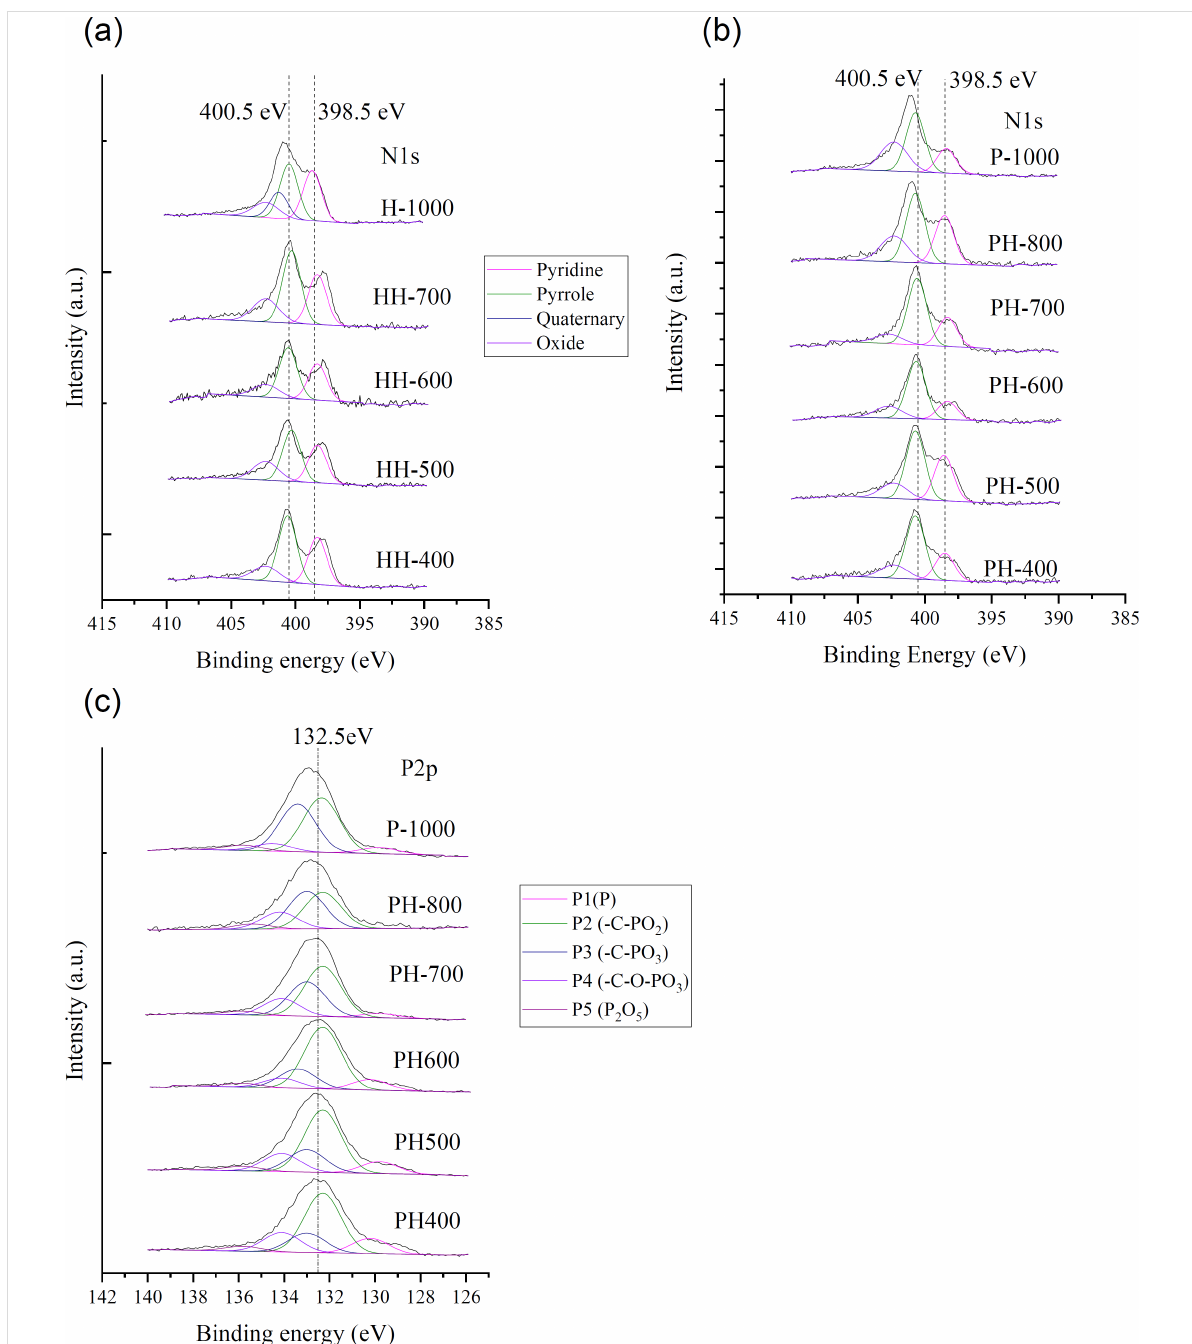
Figure 5: N 1s spectra of (a) HH- and (b) PH-series carbon materials. (c) P 2p spectra of PH-series carbon materials.